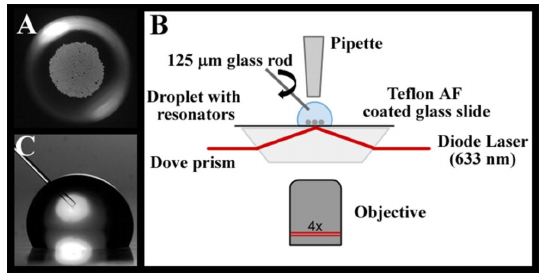
Figure 11. ( A ) Top view of some 500 barium-titanate (38 µ m in diameter) microspheres immersed